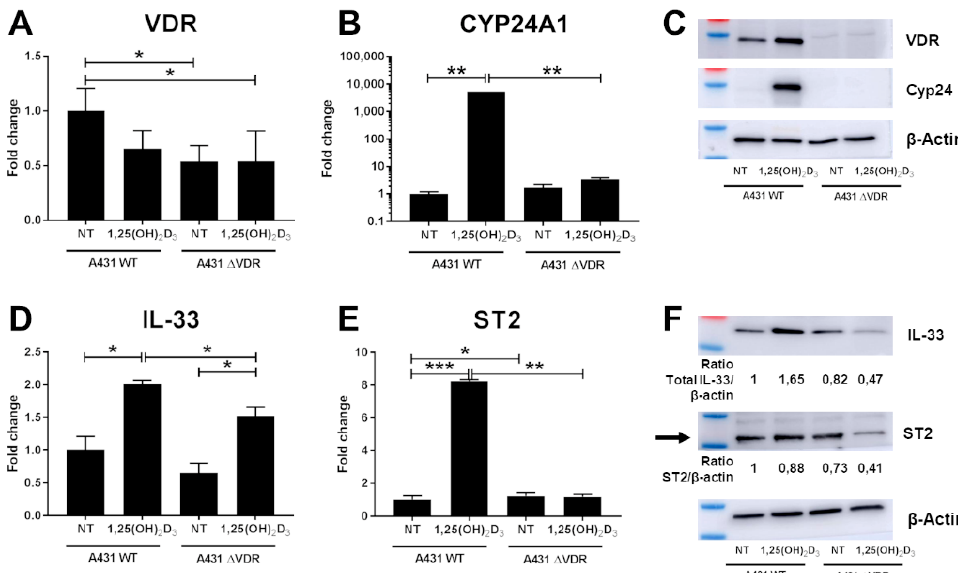
Figure 4. Knockout of VDR in the human basal cell carcinoma cell line (A431) suppressed IL-33 and ST2 induction by 1,25(OH) 2 D 3 . ( A , B ) The knockout of VDR ( A ), decreased expression CYP24A1 ( B ), was confirmed by real-time PCR in A431 cell line. IL-33 ( D ) and ST2 ( E ) mRNA expression was examined in cells with or without 1,25(OH) 2 D 3 (100 nM) treatment. Immunoblotting for VDR, CYP24 ( C ), IL-33 and ST2 ( F ) was performed on lysate from A431 WT and Δ VDR cells treated with or without 1,25(OH) 2 D 3 for 24h. Blots were stripped and re-probed with anti- β -actin antibody to normalize for differences in protein loading. * p < 0.05, ** p < 0.01, *** p < 0.001.